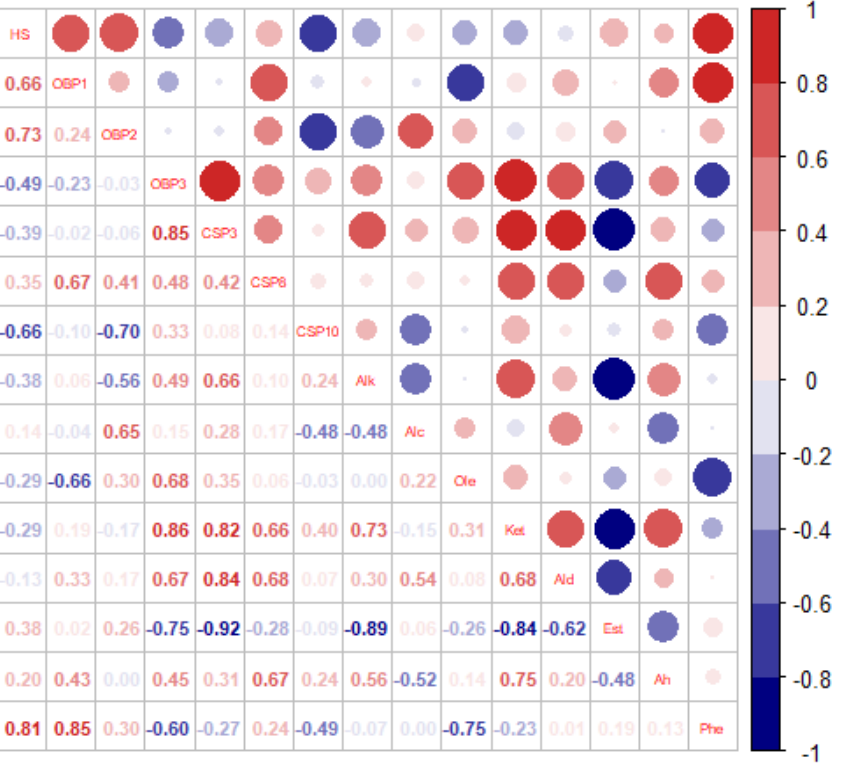
Figure 5. The Pearson analysis of the correlation among the host selection rate, the expression levels of OBPs and CSPs in N. lugens adults and the relative percentage compositions of the measured eight groups of volatile organic compounds (VOCs) from rice plants. ( Note: The scale color of the filled squares indicates the strength of the correlation (r) and whether it is negative (blue) or positive (red). The correlation is stronger when the number corresponding to the color and size of circles is closer to 1 or −1 .).